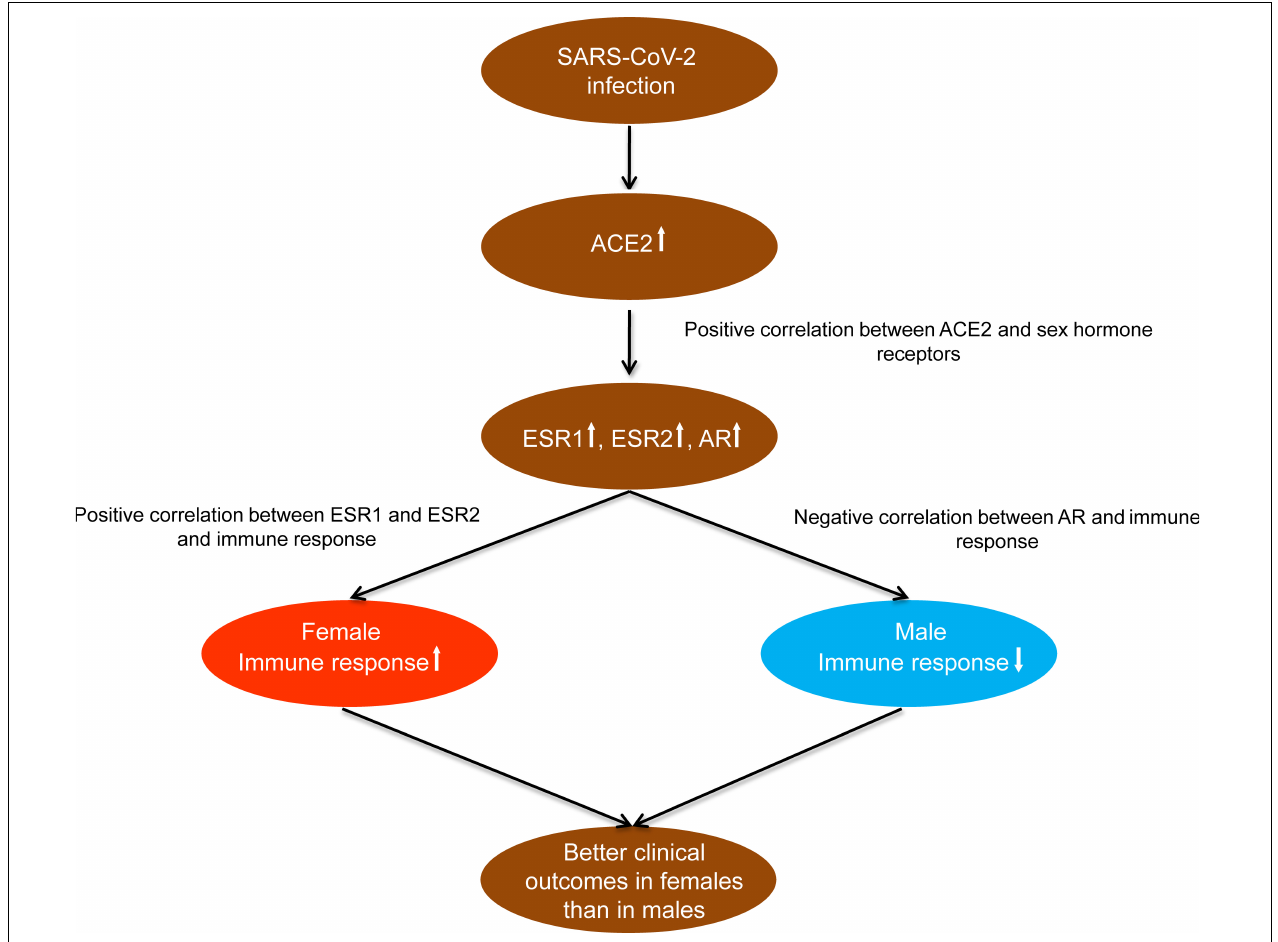
FIGURE 5 | A potential mechanism underlying the significantly different clinical outcomes of SARS-CoV-2 infections between females and